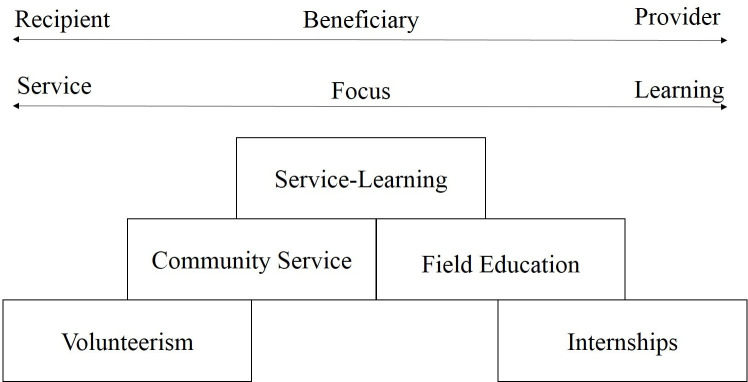
Distinctions among service programs [20].